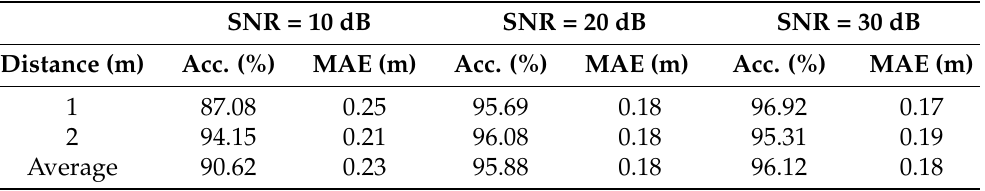
Table 4. Performance of distance estimation by CNN-R in a single acoustic environment.